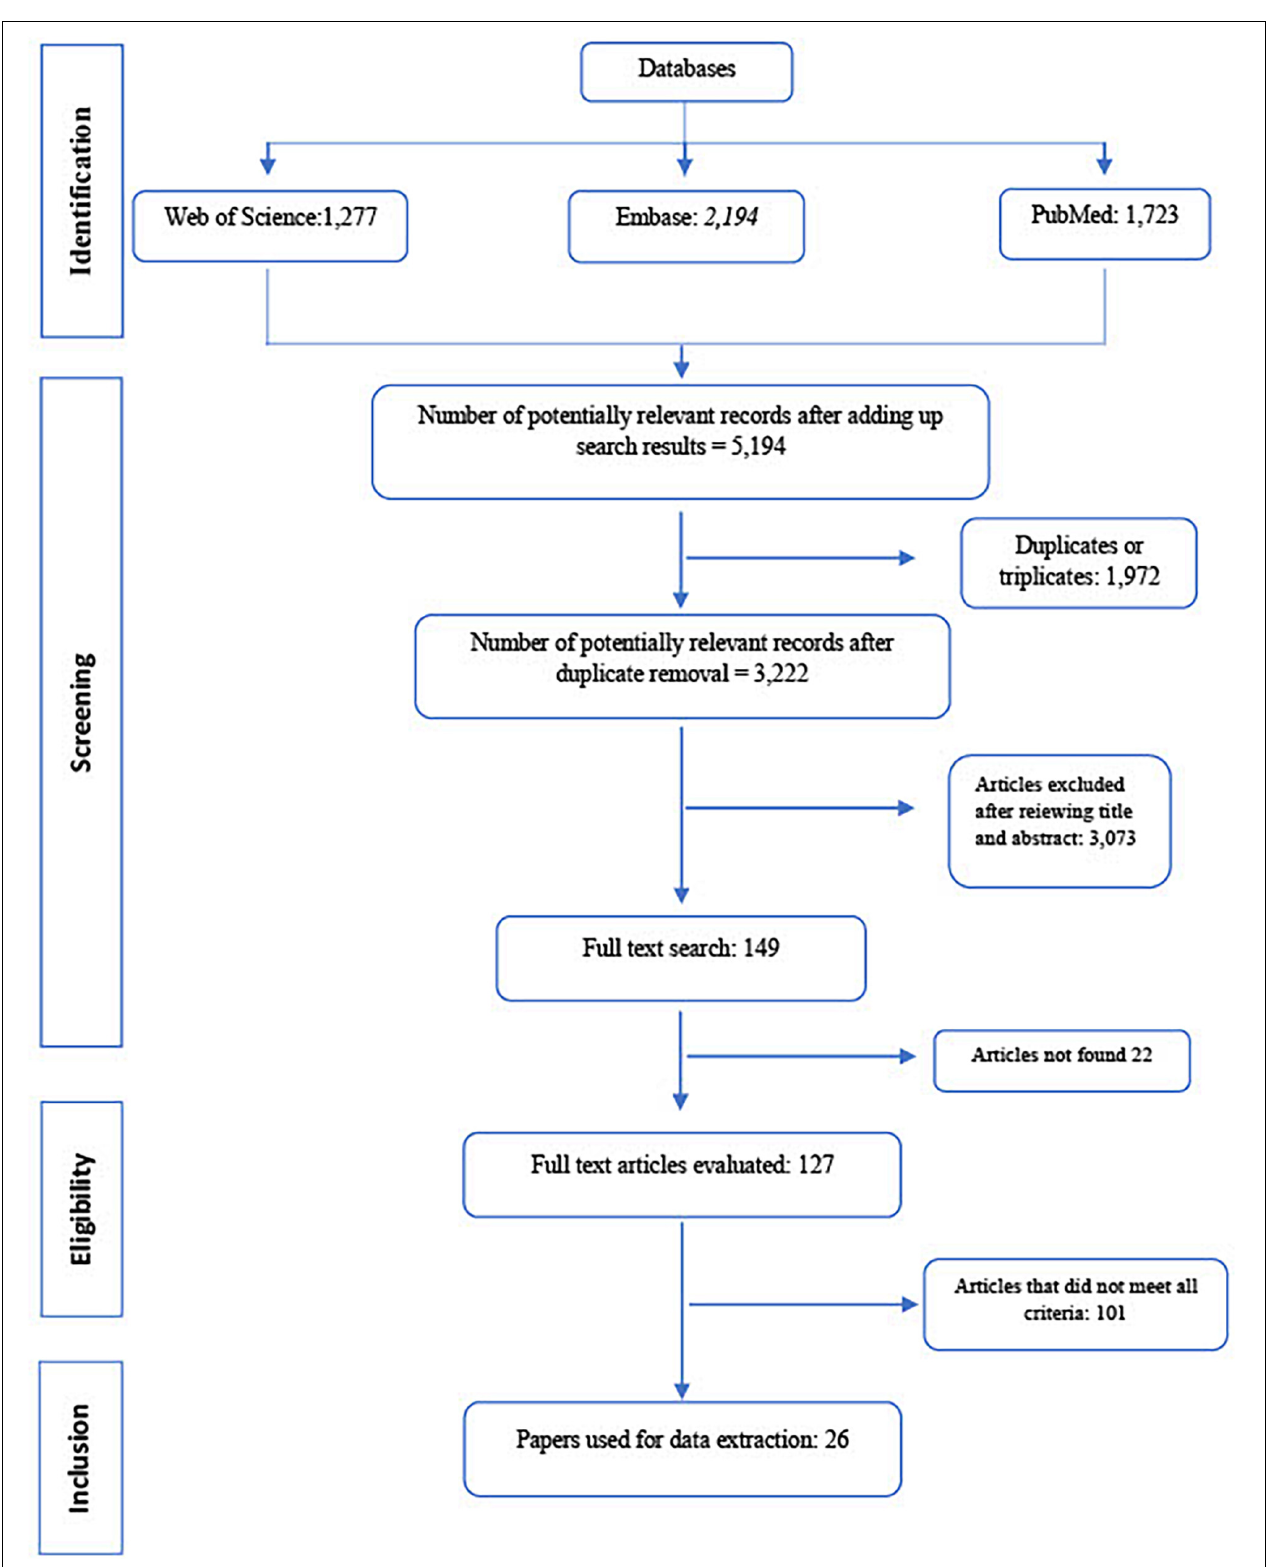
FIGURE 1 | PRISMA flow diagram showing the sequential steps for articles selection and inclusion in the meta-analysis.